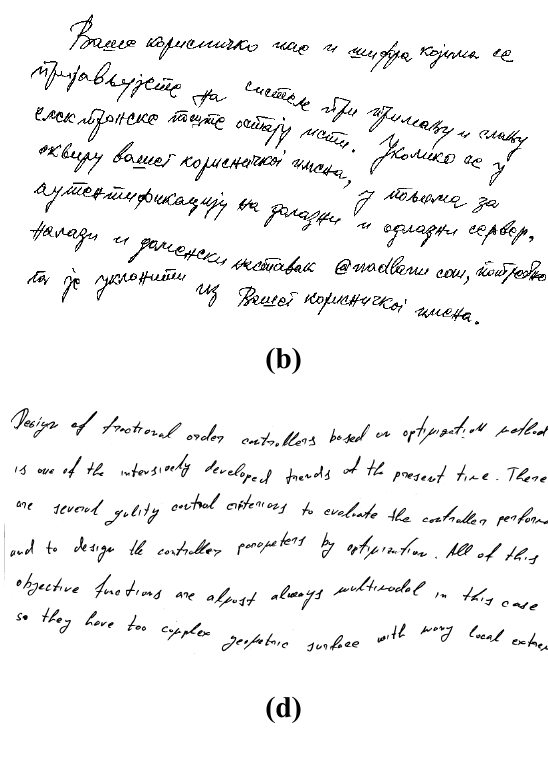
Figure 5. Multi-line handwritten text fragments: (a) Serbian Latin text. (b) Serbian Cyrillic text. (c) Cyrillic text. (d) English